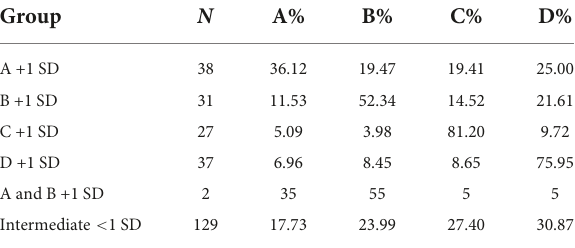
TABLE 5 Mean percentages of individual deck choices (trials 61–100) in the IGT for each subgroup of extreme individuals in each choice based on +1 standard deviation (SD).